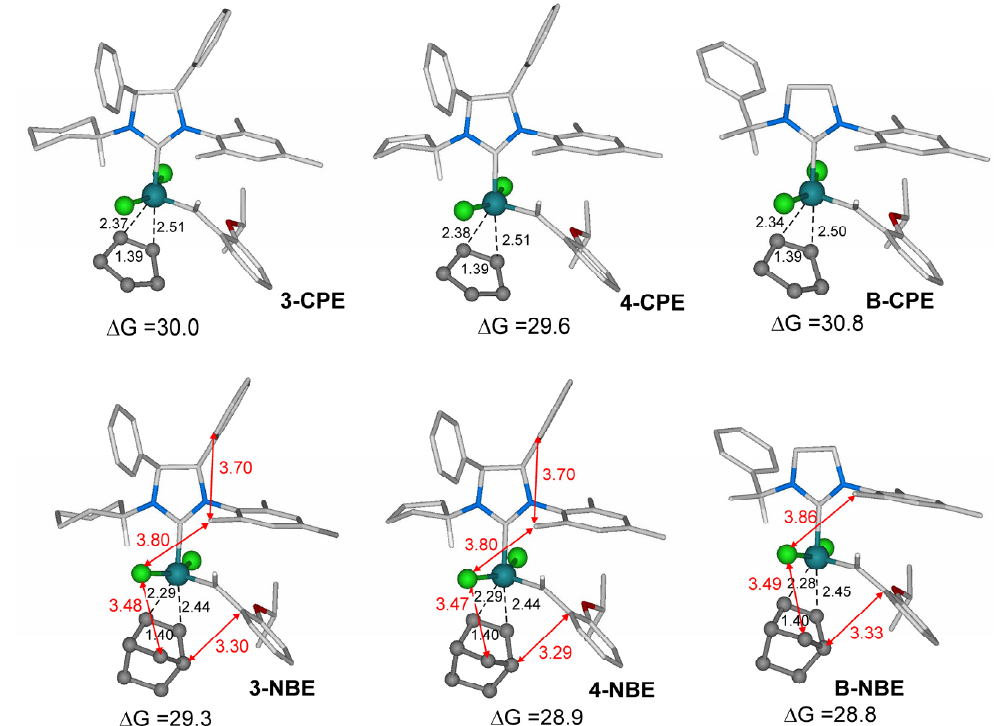
Figure 9. CPE and NBE minimum energy coordination structures for catalyst 3 ( 3-CPE and 3-NBE ), catalyst 4 ( 4-CPE and 4-NBE ) and Buchmeiser catalyst ( B-CPE and B-NBE ). Free energies of CPE and NBE coordination in CH 2 Cl 2 are in kcal/mol. Table 3. % V Bur, ∆∆ G monomer coordination and Ru charge of 3 , 4 and Buchmeiser catalyst.